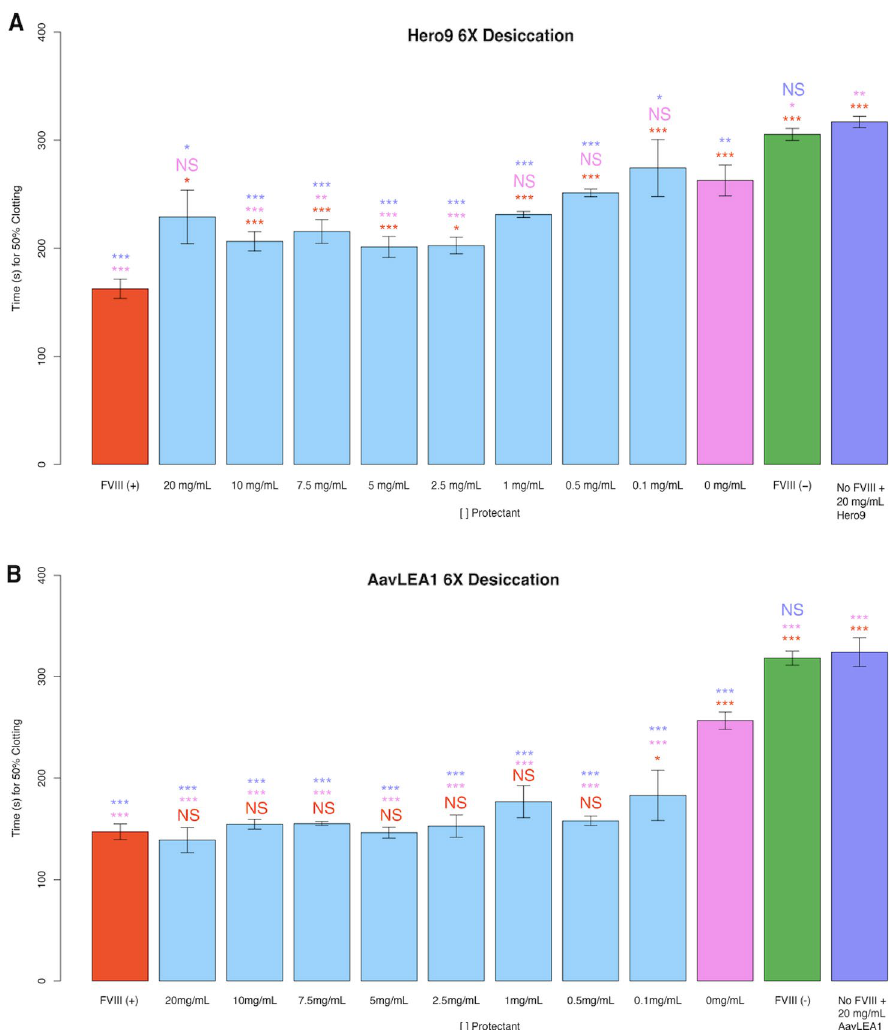
Figure 4. Non-CAHS IDPs’ protective capacity during repeated desiccation cycles. Histograms of the 50% clotting time of FVIII with different treatments ( A ) Hero9 and ( B ) AavLEA1. The red “FVIII (+)” bar represents FVIII deficient human blood plasma treated with FVIII. All red notations above sample bars represent statistical comparison with “FVIII (+).” “X mg/mL” notations beneath sample bars correspond to the concentrations of AavLEA1 or Hero9, mixed with FVIII before desiccation. All pink notations above sample bars represent statistical comparison with “0 mg/mL.” The green “FVIII (−)” bar represents FVIII deficient human blood plasma treated with no FVIII. “No FVIII + X mg/mL AavLEA1 or Hero9” represents FVIII deficient human blood plasma treated with X mg/mL AavLEA1 or Hero9, but no FVIII. All purple notations above sample bars represent statistical comparison with “No FVIII + X mg/mL, AavLEA1, or Hero9.” Notations above sample bars represent statistical significance determined by one-way ANOVA and Tukey’s post- hoc test. Error bars represent bi-directional standard deviation. P value > 0.05 = NS, P < 0.05 = *, P < 0.01 = **, P < 0.001 =